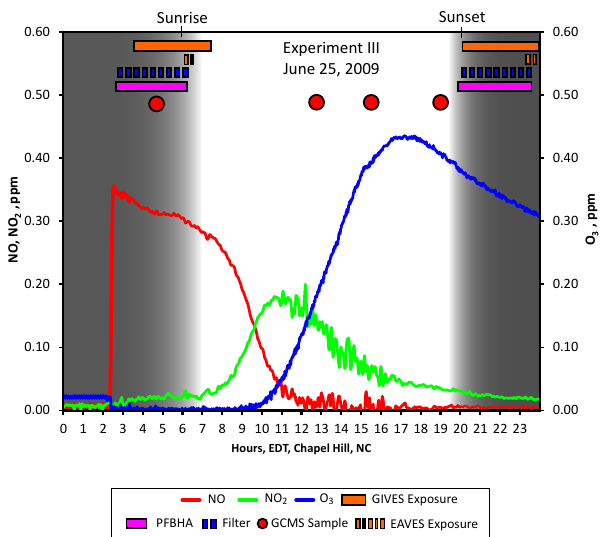
Fig. 4. Time series of explicit or type-identified, secondary VOCs produced during experiment III (JN2509), performed with SynUrb54 and NO x injected in the dark at 02:30EDT. The sym- bol between carbon number names means “or”; the functionality is specified if known, the carbon chain length is estimated by retention times. Colored bars and large red dots are as in Fig. 2. See Table 4 for mixing ratio values at specific time